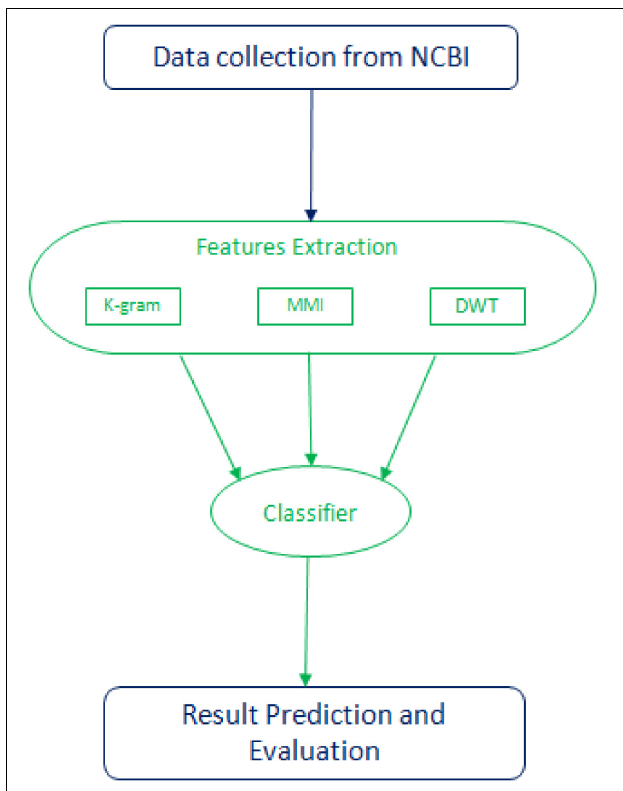
FIGURE 2 | Flow chart of the methodology followed in this